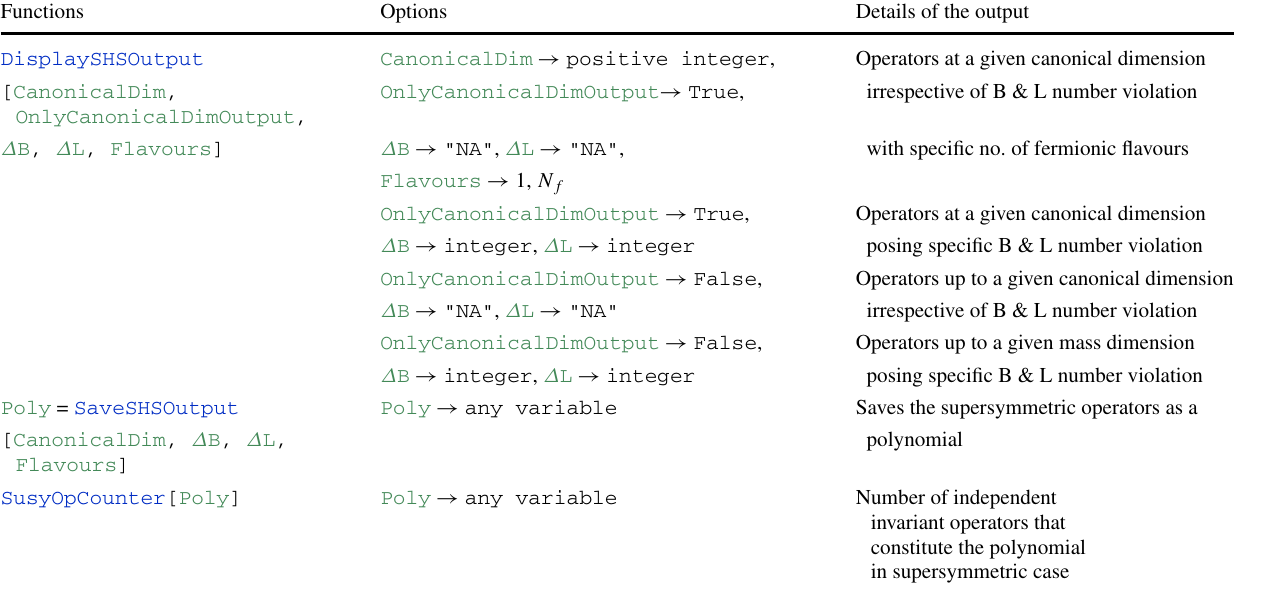
Table 15 GrIP SUSY functions and their working principles